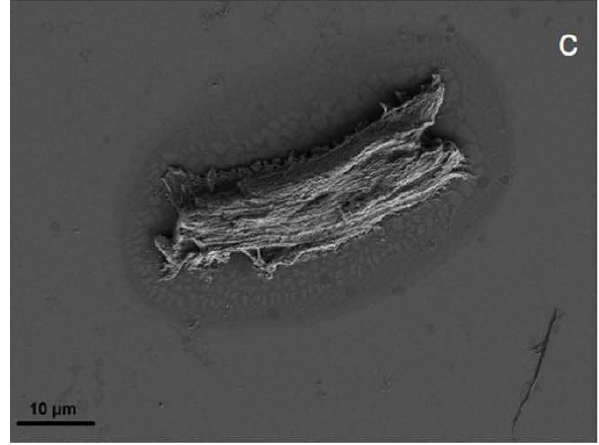
Figure 6. PS particle generated by sonication, Reprinted with permission from ref. [213], Copyright 2020 Frontiers of Chemistry, Elisabeth von der Esch; Maria Lanzinger; Alexander J. Kohles; Christian Schwaferts; Jana Weisser; Thomas Hofmann; Karl Glas; Martin Elsner and Natalia P. Ivleva.